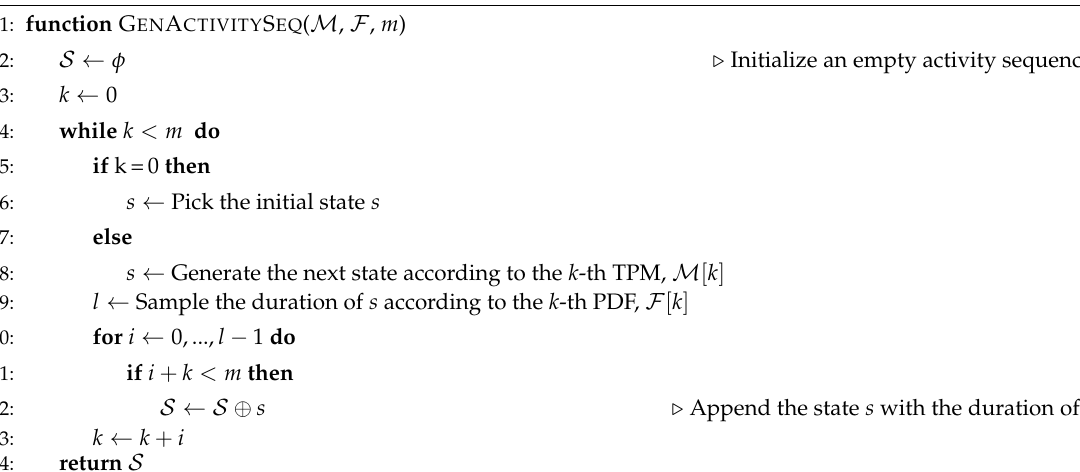
Algorithm 1 Generating an individual activity